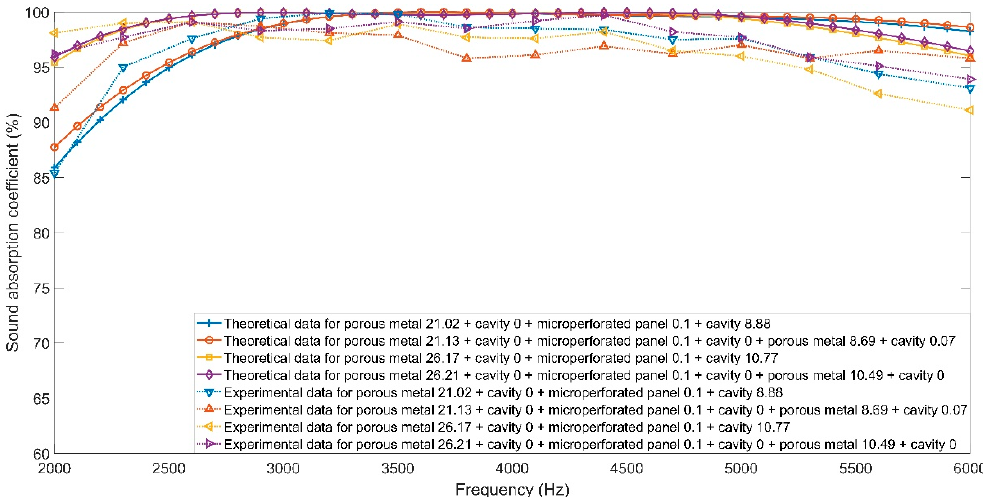
Figure 9. Comparisons of the sound absorption coe ffi cients in theory and those in experiment. Table 6. Quantitative comparisons of average sound absorption coe ffi cients in the frequency range (2000 Hz, 6000 Hz) in the theoretical result, the simulation result, and the experimental